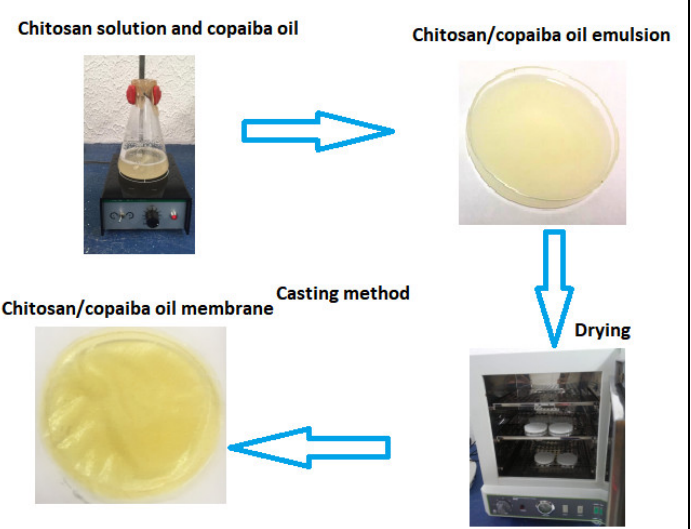
Figure 1. Schematic diagram of the synthesis of chitosan membranes/copaiba oil by the casting method.